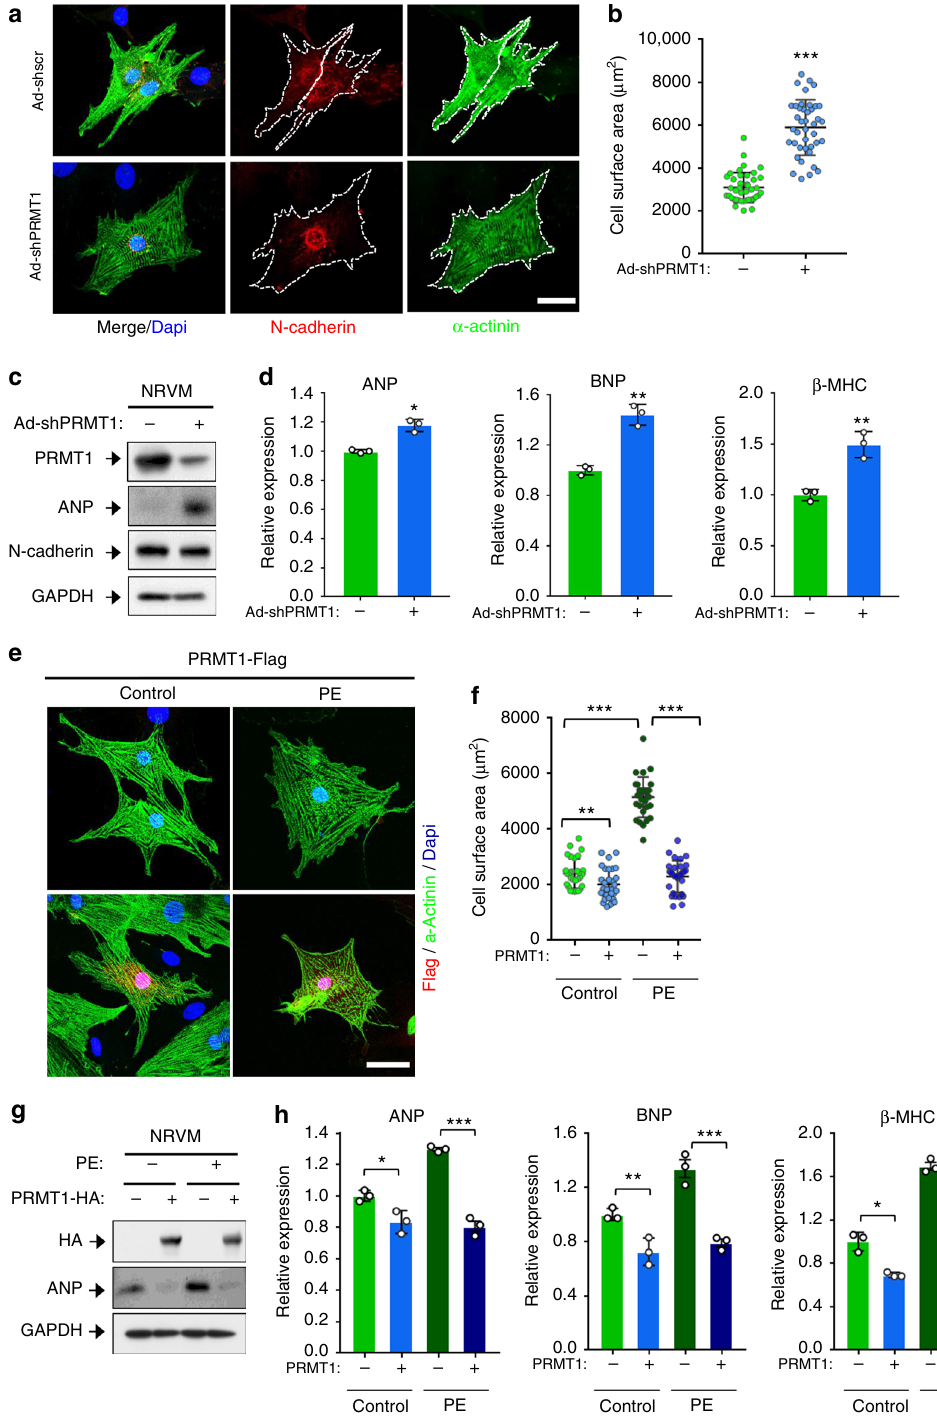
Fig. 3 PRMT1 depletion causes cardiomyocyte hypertrophy while its overexpression prevents phenylephrine-induced hypertrophy. a Representative immunostaining images of NRVM cells infected with Ad-shscr (adenovirus-sh scrambled RNA) and Ad-shPRMT1 (adenovirus-PRMT1 shRNA). The white dashed line indicates a single cell surface. Scale bar: 50 μ m. b Quanti fi cation of cell surface area as shown in a . n = 82 (Ad-shscr); n = 70 (Ad-shPRMT1). Data represent means± SD. *** P < 0.005, Student ’ s t -test. c Immunoblot analysis of NRVM/Ad-shscr or NRVM/Ad-shPRMT1 cells. d qRT-PCR analysis of ANP, BNP, and β -MHC expression in NRVM/Ad-shscr and NRVM/Ad-shPRMT1. n = 3. Data represent means ± SD. * P < 0.05, ** P < 0.01, Student ’ s t -test. e Immunostaining images of PRMT1-Flag transfected NRVM cells (red staining) treated with control or phenylephrine (PE) for 48 h. Scale bar: 50 μ m. f Quanti fi cation of the surface area of cells similar shown in e . n = 56 (vehicle-pcDNA); n = 54 (vehicle-PRMT1- fl ag); n = 52 (PE-pcDNA); n = 48 (PE- PRMT1- fl ag). Data represent means ± SD. * P < 0.05, ** P < 0.01, *** P < 0.001, Student ’ s t -test. g Protein analysis of control or PRMT1-HA transfected NRVM cells treated with vehicle or PE for 48 h for PRMT1 and ANP. h qRT-PCR analysis of ANP, BNP, and β -MHC levels in control or PRMT1-HA transfected NRVM cells treated with vehicle or PE. n = 3. Data represent means ± SD. * P < 0.05, ** P < 0.01, *** P < 0.001, Student ’ s t